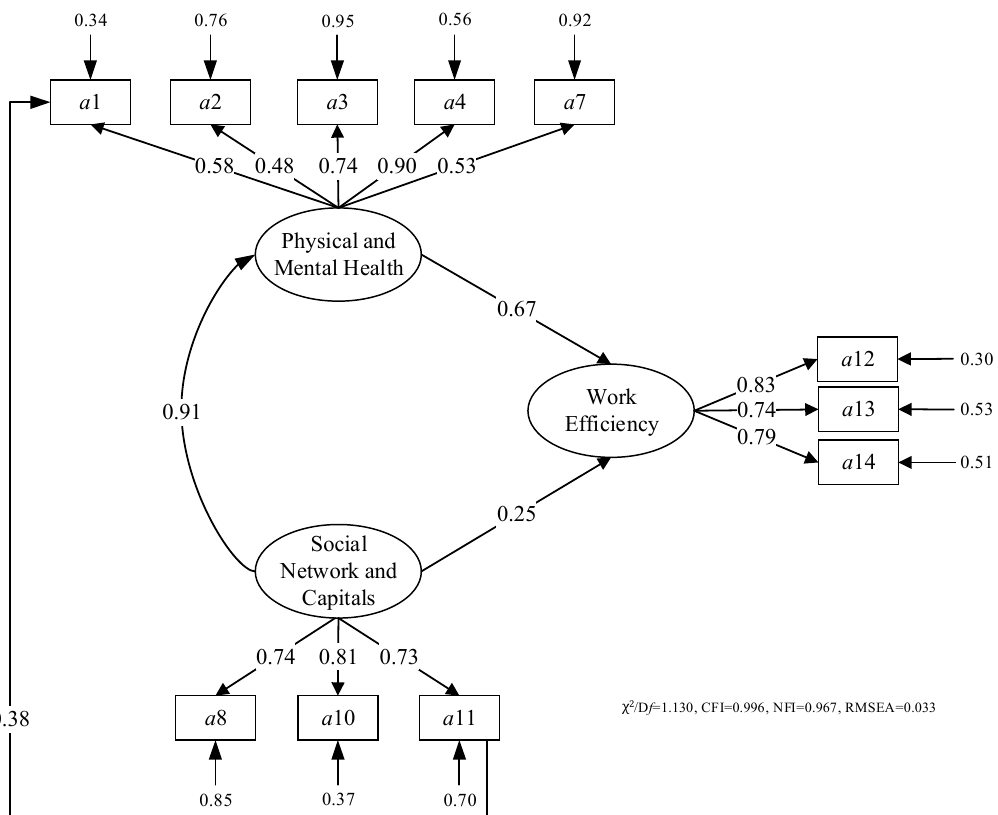
Figure 4. Pathway coefficients for the improved model for SEM.